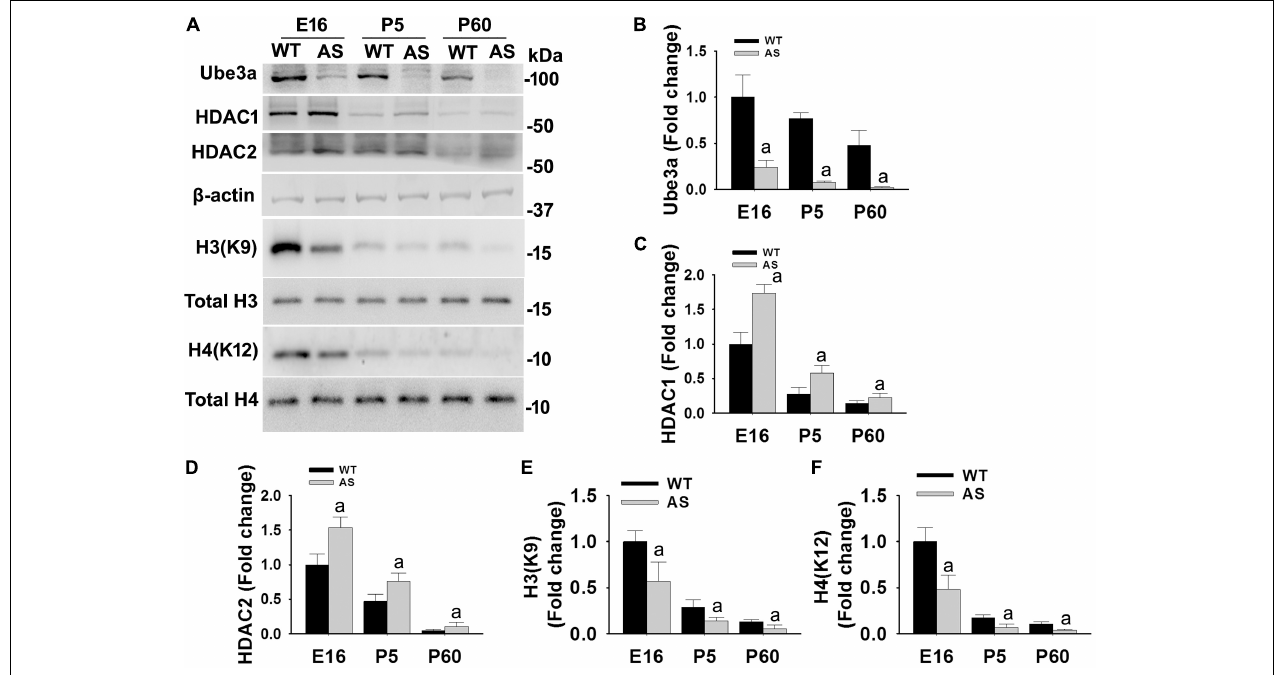
FIGURE 1 | AS mice exhibit increased levels of HDAC1 and HDAC2 along with hypo-acetylation of histones H3(K9) and H4(K12) from early developmental days. (A) Cortical brain regions obtained from both wild type and AS mice at their different developmental stages (E16, P5, and P60) were processed for immunoblot analysis using antibodies against HDAC1 and HDAC2, various histones and their acetylated derivatives. (B–F) Densitometric analysis of the band intensity using ImageJ software. Band intensities of Ube3a (B) , HDAC1 (C) , and HDAC2 (D) were measured, divided by the band intensity of respective β -actin to normalize and expressed as fold change, while acetylated histones H3(K9) and H4(K12) were normalized against respective total histone (acetylated/total) and expressed as fold change. Values are mean ± SD with four animals in each group. The “a” indicate p < 0.05 compared to respective wild type group at E16, P5 and P60. Values were analyzed by two-way ANOVA with Holm–Sidak post-hoc